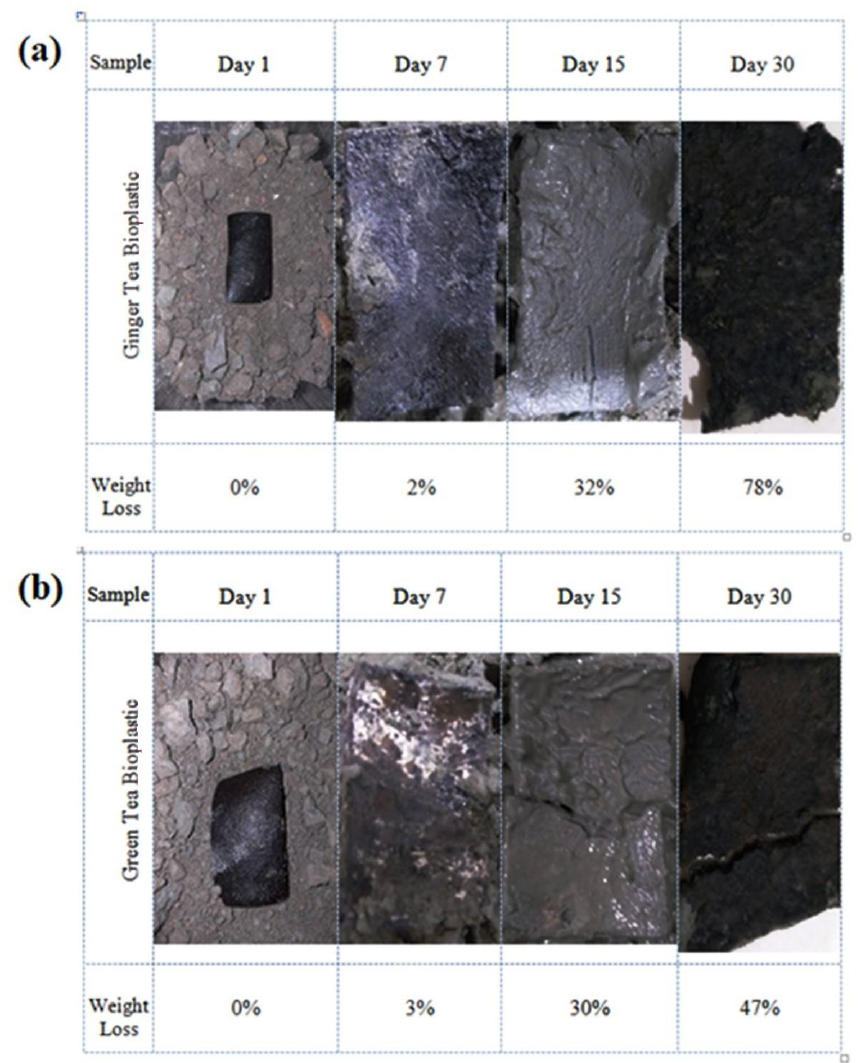
Figure 8. Bioplastic samples before and after biodegradation test synthesized by ( a ) ginger tea and ( b ) green tea. ( b ) green